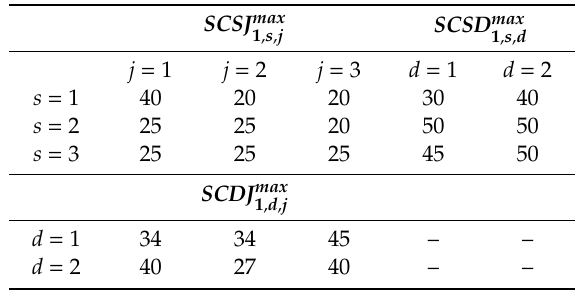
Table A17. Maximum loading capacity per shipment of product 1